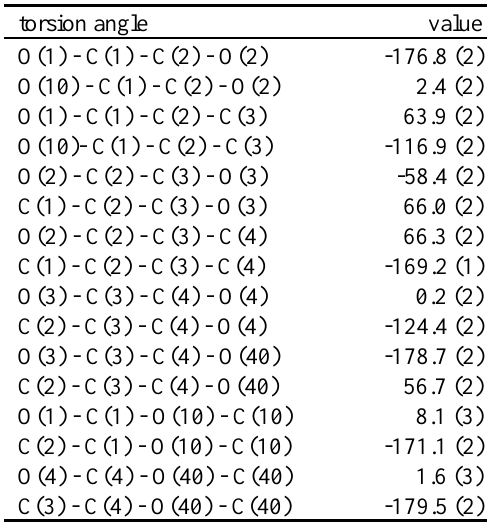
Table 3. Torsion angles ( o